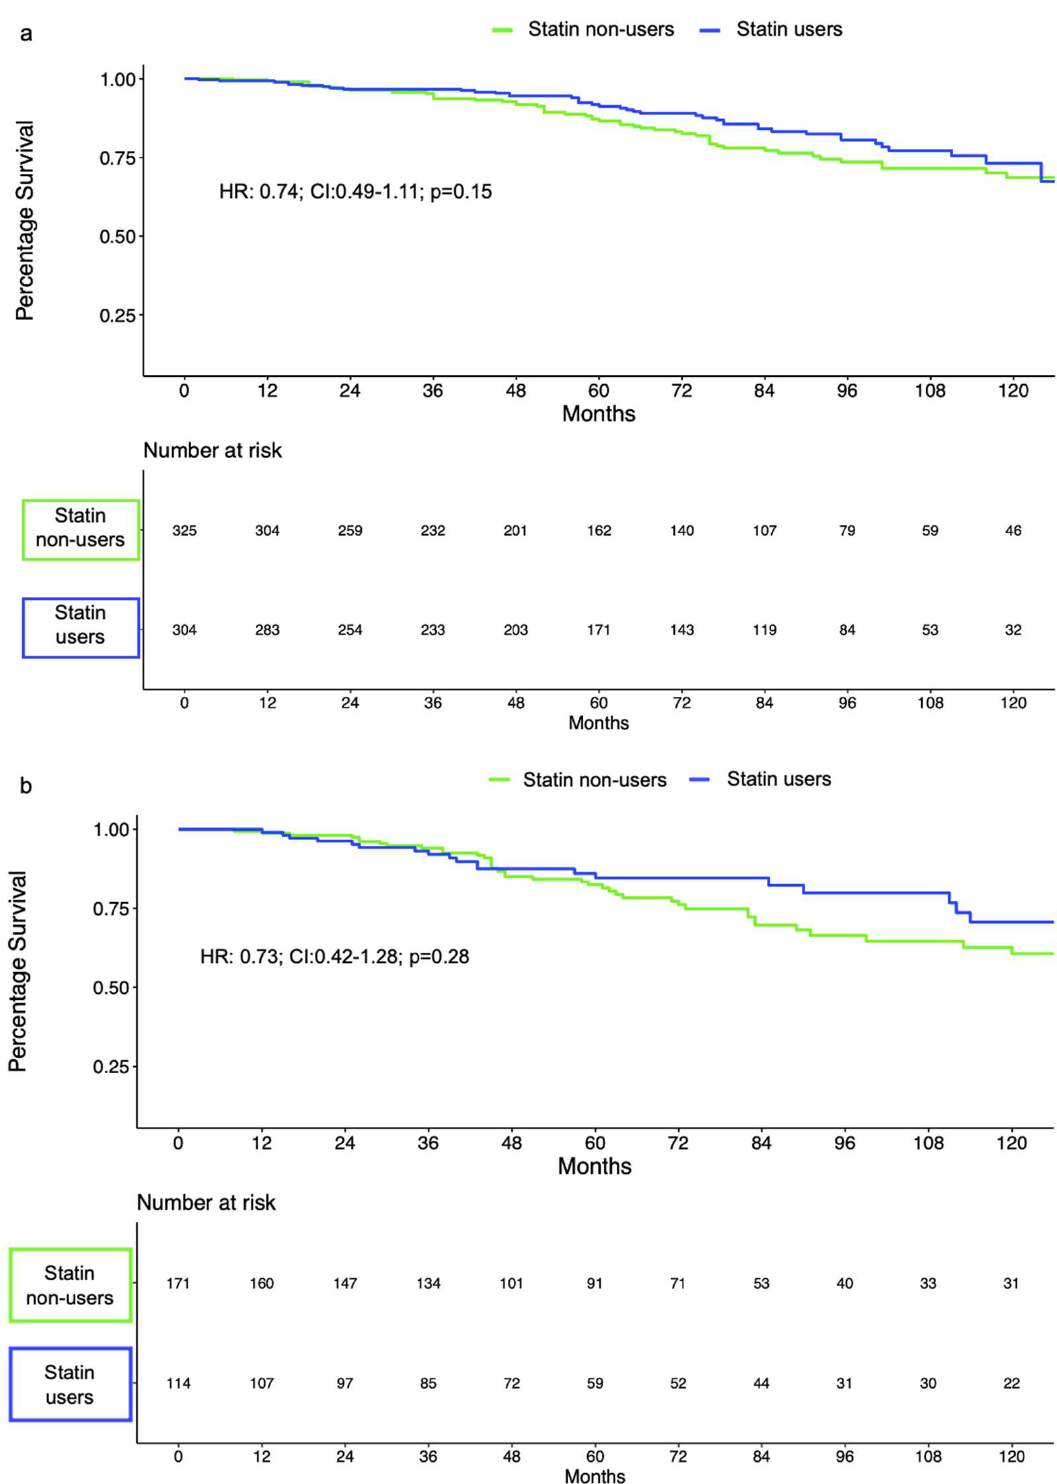
Figure 2. BCR-free survival in D’Amico intermediate-risk ( a ) and high-risk ( b ) patients treated with EBRT. Table 3. Univariable and multivariable Cox regression models predicting biochemical recurrence among EBRT-treated patients (intermediate- and high-risk), according to statin use.